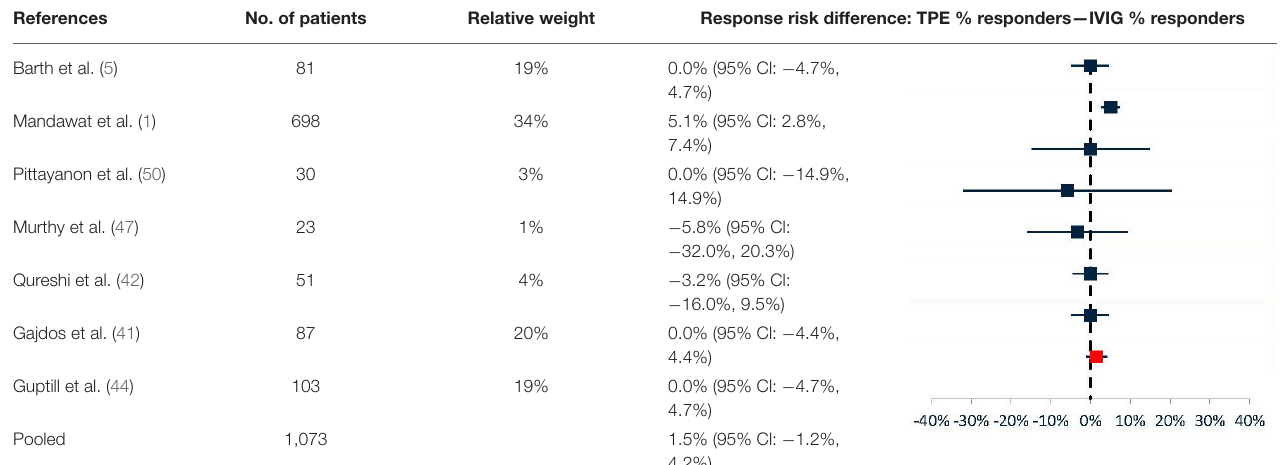
TABLE 6 | Results of meta-analysis (TPE vs. IVIG) of mortality risk difference in acute MG.